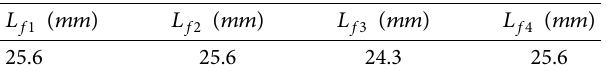
Table 3: Dimension of feed lines for design 3dB ATRD coupler has been described in Example